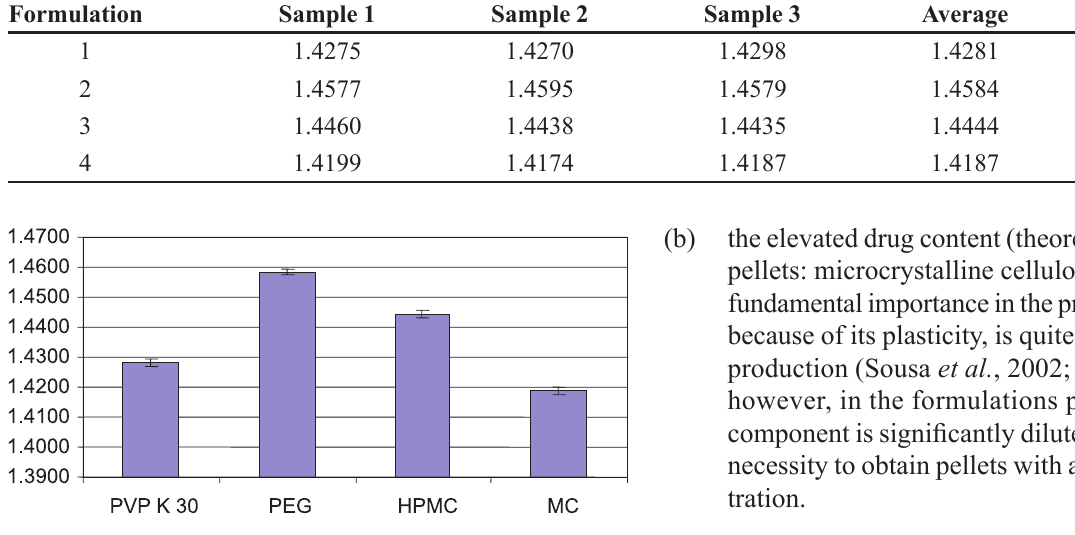
FIGURE 3 - Graphic representation of the true density values obtained for formulations 1 (PVP K30), 2 (PEG), 3 (HPMC) and 4 (MC). The bars indicate the respective standard